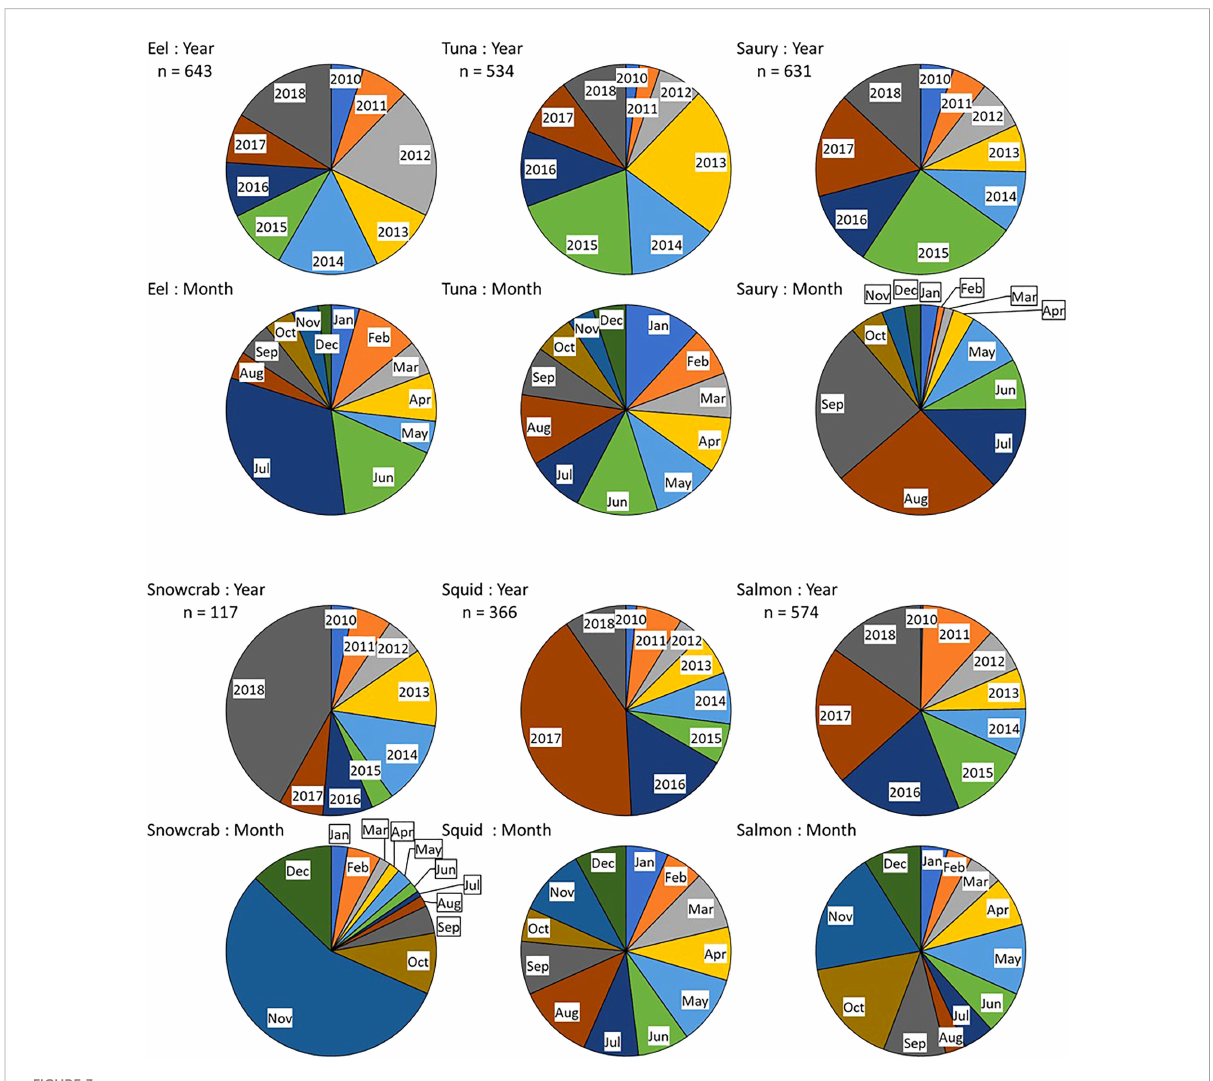
FIGURE 3 Yearly and monthly trend of the public inquiries for six signi fi cant species. (To note, all the six signi fi cant species showed the data from 2010 because there were no relevant inquiry records during 2004 and 2009 on the internal DB. This is partly due to the very small record during this period (see Tables A3, A4 for the full